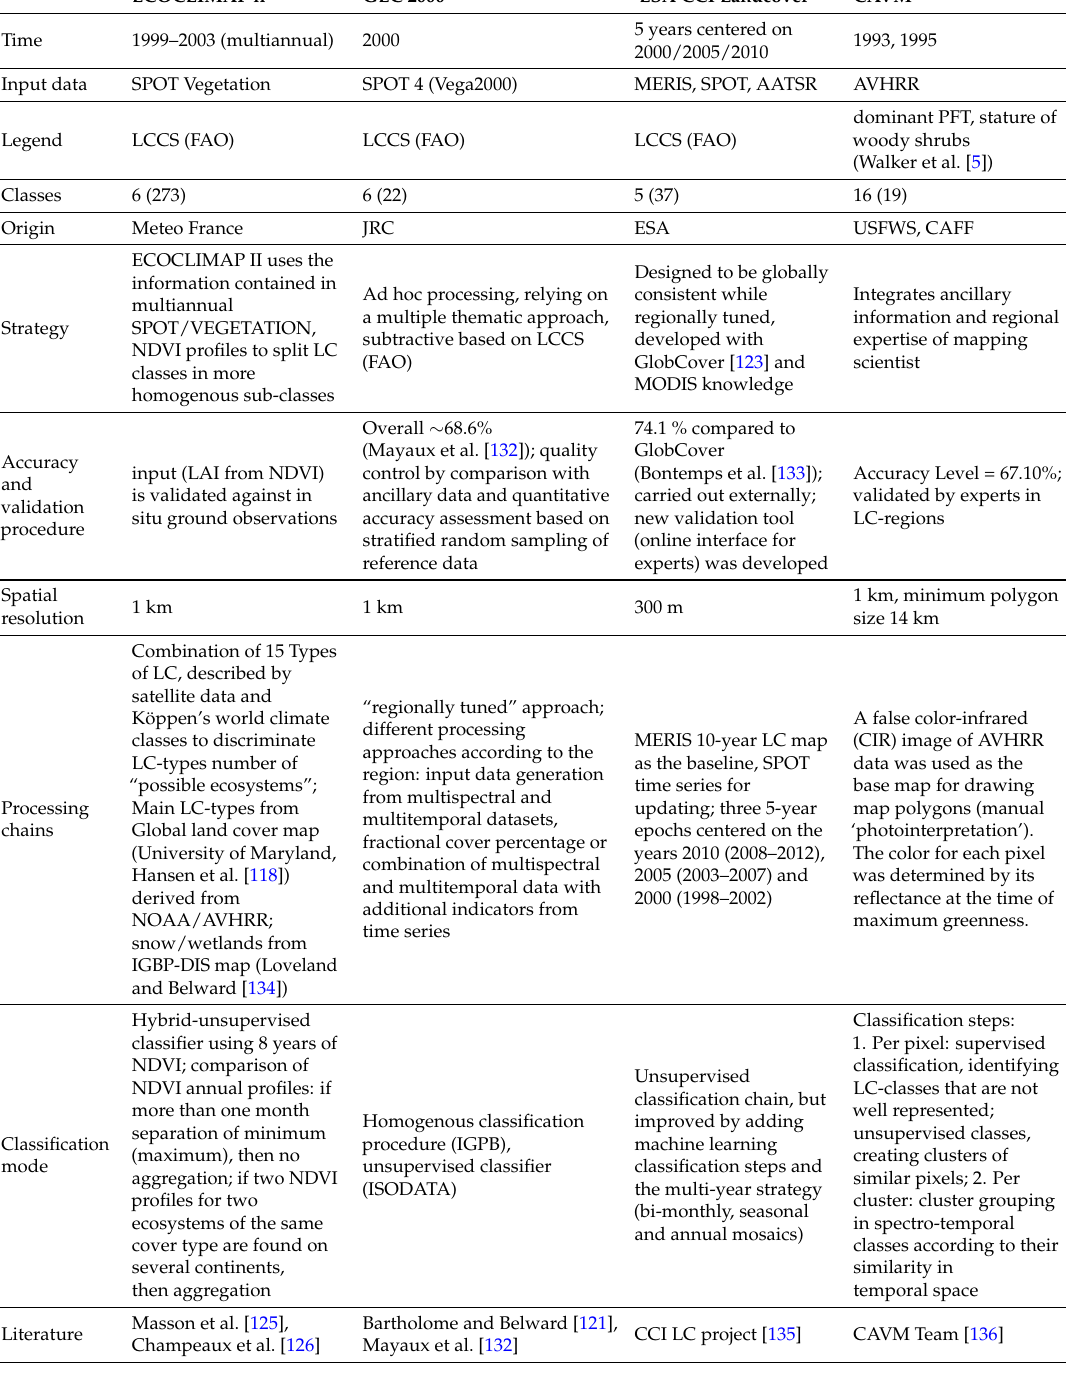
Table 2. Details of selected global land cover maps and CAVM. The number of classes refers to none-water/ice classes >1% within CAVM